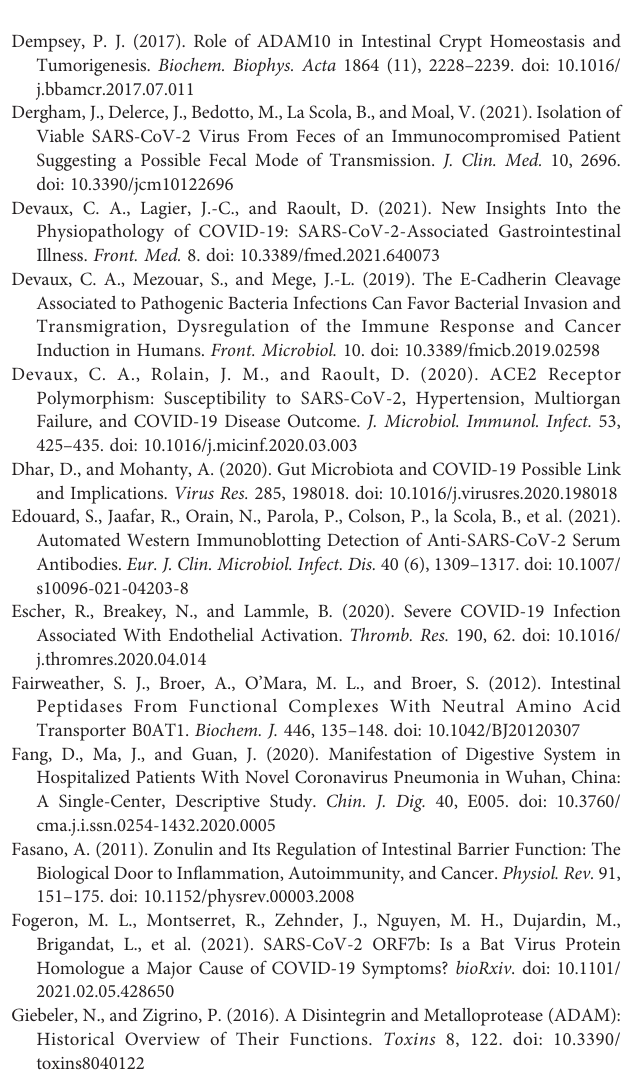
Supplementary Figure 1 | Relative expression of different cellular mRNA in virus- free Caco-2 cells, in particular the mRNA encoding SARS-CoV-2 receptor/ coreceptors as well as AngII and Ang-(1-7) receptors, and mRNA encoding cell adhesion and tight junctions molecules. The results are expressed as RE where RE = 2 ( − D CT) . Supplementary Figure 2 | (A) Relative expression of different cellular mRNA in virus-free HT29 cells, in particular the mRNA encoding SARS-CoV-2 receptor/ coreceptors as well as AngII and Ang-(1-7) receptors, and mRNA encoding cell adhesion molecules. The results are expressed as RE where RE = 2 ( − D CT) . (B) Confocal microscope analysis of E-cad, ACE2, occludin and actin expression on virus-free HT29 cells. The experiment was performed using cells permeabilized with 0.1% Triton X-100 (upper panel) and unpermeabilized cells (lower panel). (C) Quanti fi cation of theviral release from HT29 cell byqRT-PCR: D CT represents the CT value obtained subtracted from the CT value at time T=0 (CT - CT 0 ), where T=0 is the moment immediately after removing the inoculum used in the adsorption step. Each value isthe mean of triplicates. (D) Quanti fi cation ofSARS-CoV-2 viral antigen in the HT29 cells exposed to the virus at an MOI of 0.5 for 4 hours, 24 hours and 48 hours, by antibody-detection of SARS-CoV-2 nucleocapsid protein using high-speed capillary electrophoresis JessTM automated immunoblotting system. Although the HT29 cells can beinfected by SARS-CoV-2 (as shown in D ), viral release was too low to be quanti fi able in the culture supernatants of HT29 cells (as shown in C